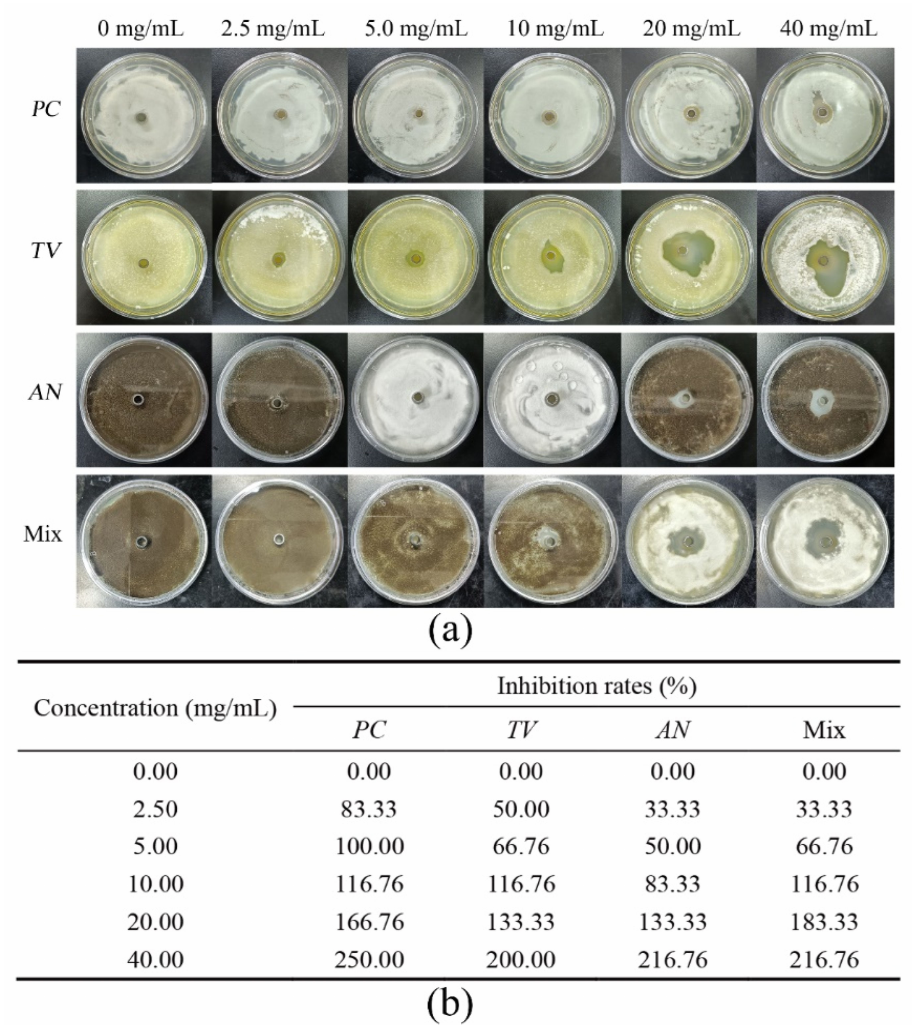
Figure 2. Results of inhibition zone and inhibition rate of different benzyldimethyldodecylammonium chloride concentrations against bamboo mildew. ( a ) Inhibition zone results; ( b ) inhibition